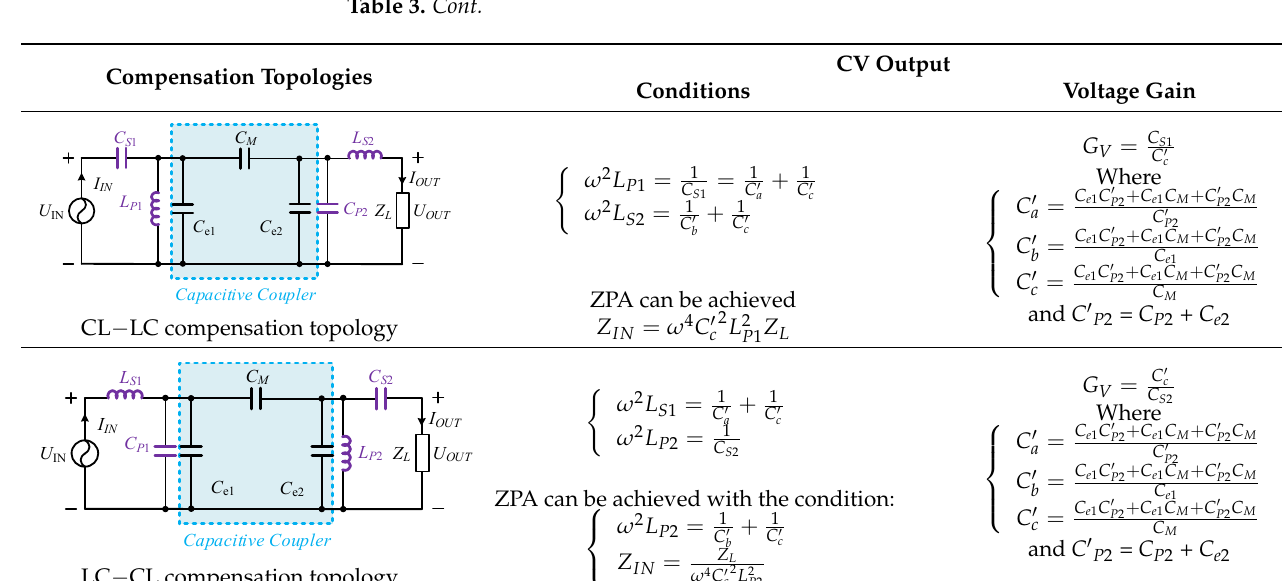
Z Table 3. Comparison of SP-based compensation topologies to achieve CV output. Compensation Topologies